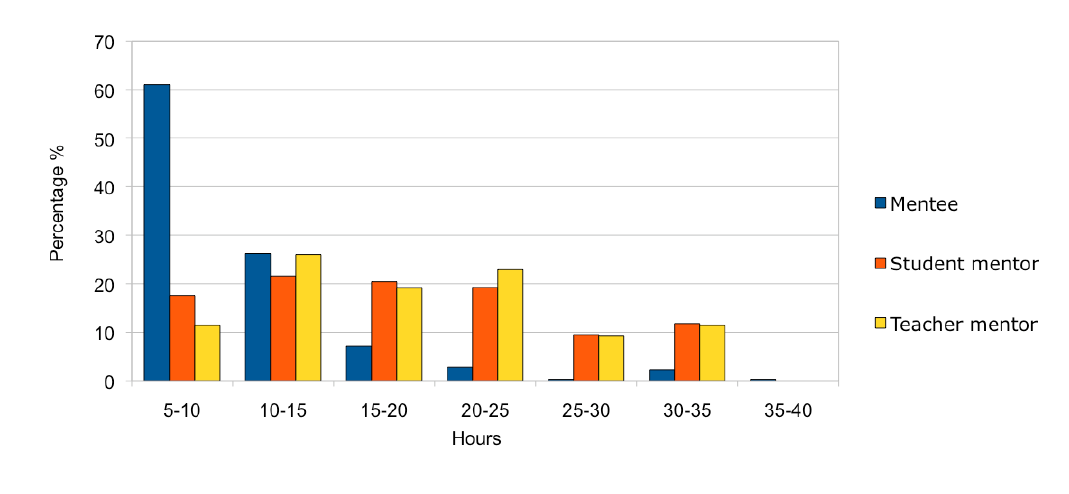
Figure 1. “Hours spent in the